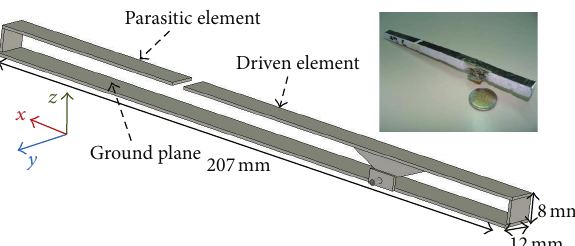
Figure 9: Measured reflection coefficient for the two PIFAs in [16, 18], in the DVB-T band.